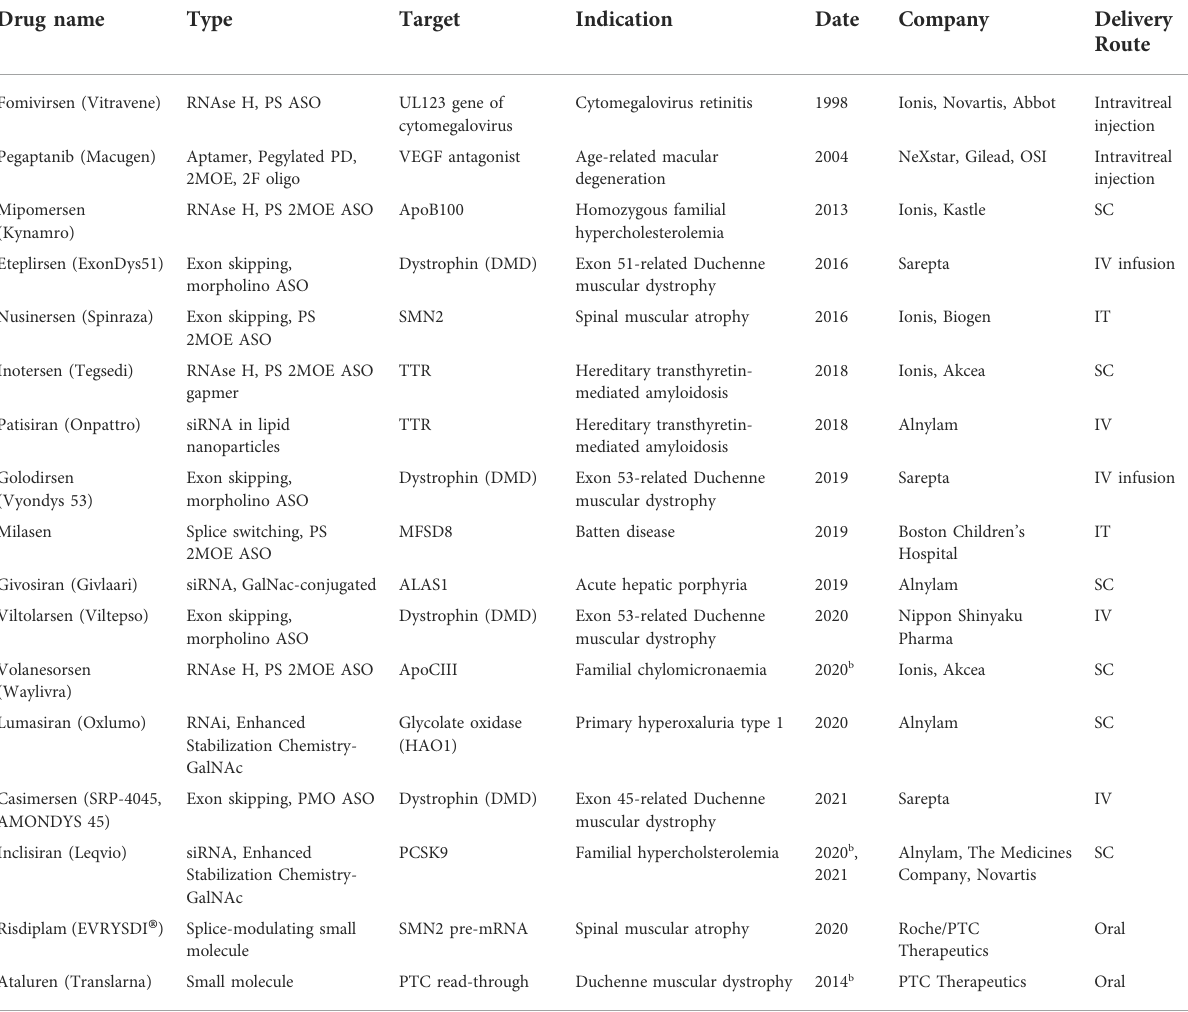
TABLE 1 Nucleic acid-based therapeutics and RNA-targeting small molecules a